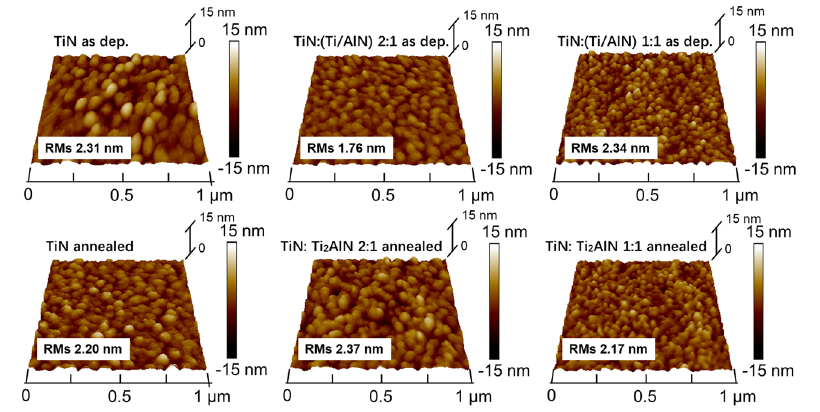
Figure 4. AFM image of the TiN/(Ti/AlN) and TiN/Ti 2 AlN multilayers.